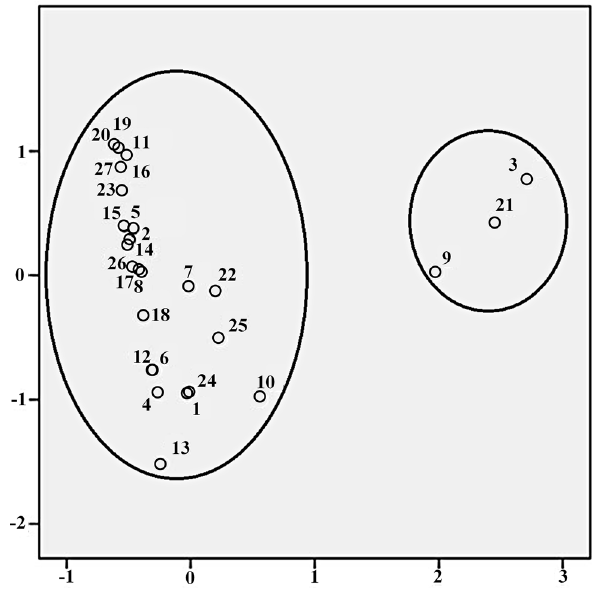
Fig. 3 MCA categorizes water quality monitoring stations at Huaihe River basin based on mean values of water quality